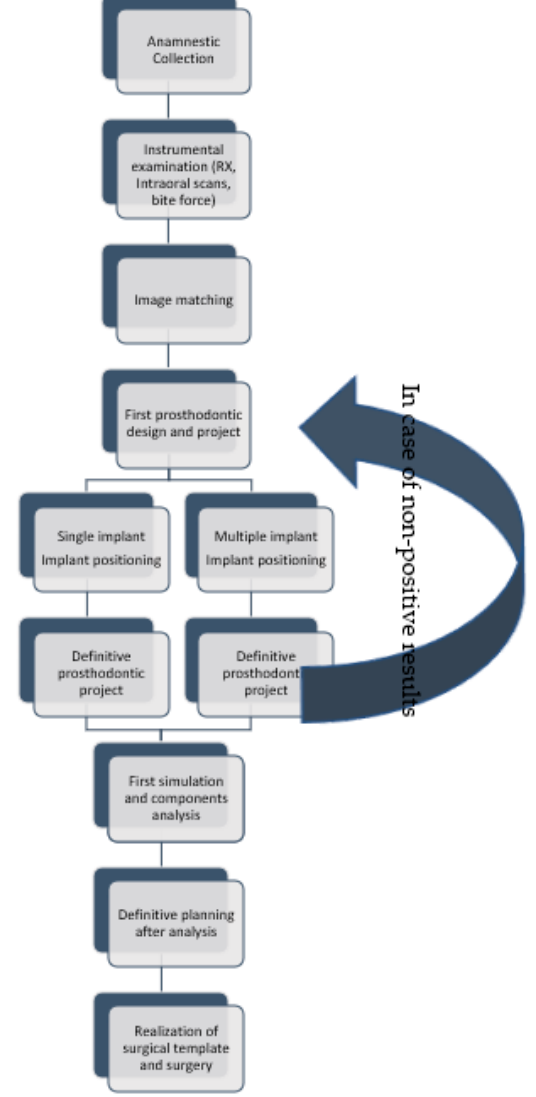
Figure 5. Digital-assisted pre-guided implant surgery workflow.